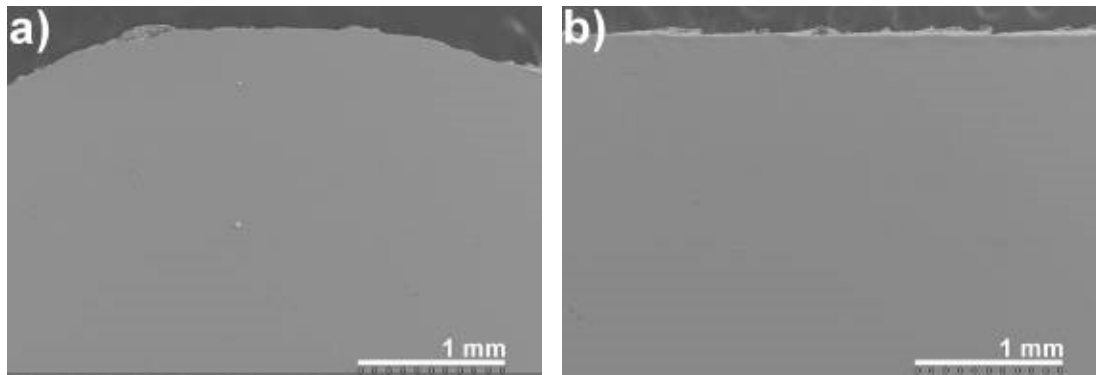
Figure 10. The results obtained for the polished samples using the SEM technique. Variant V1: ( a ) transverse section, ( b ) longitudinal section.